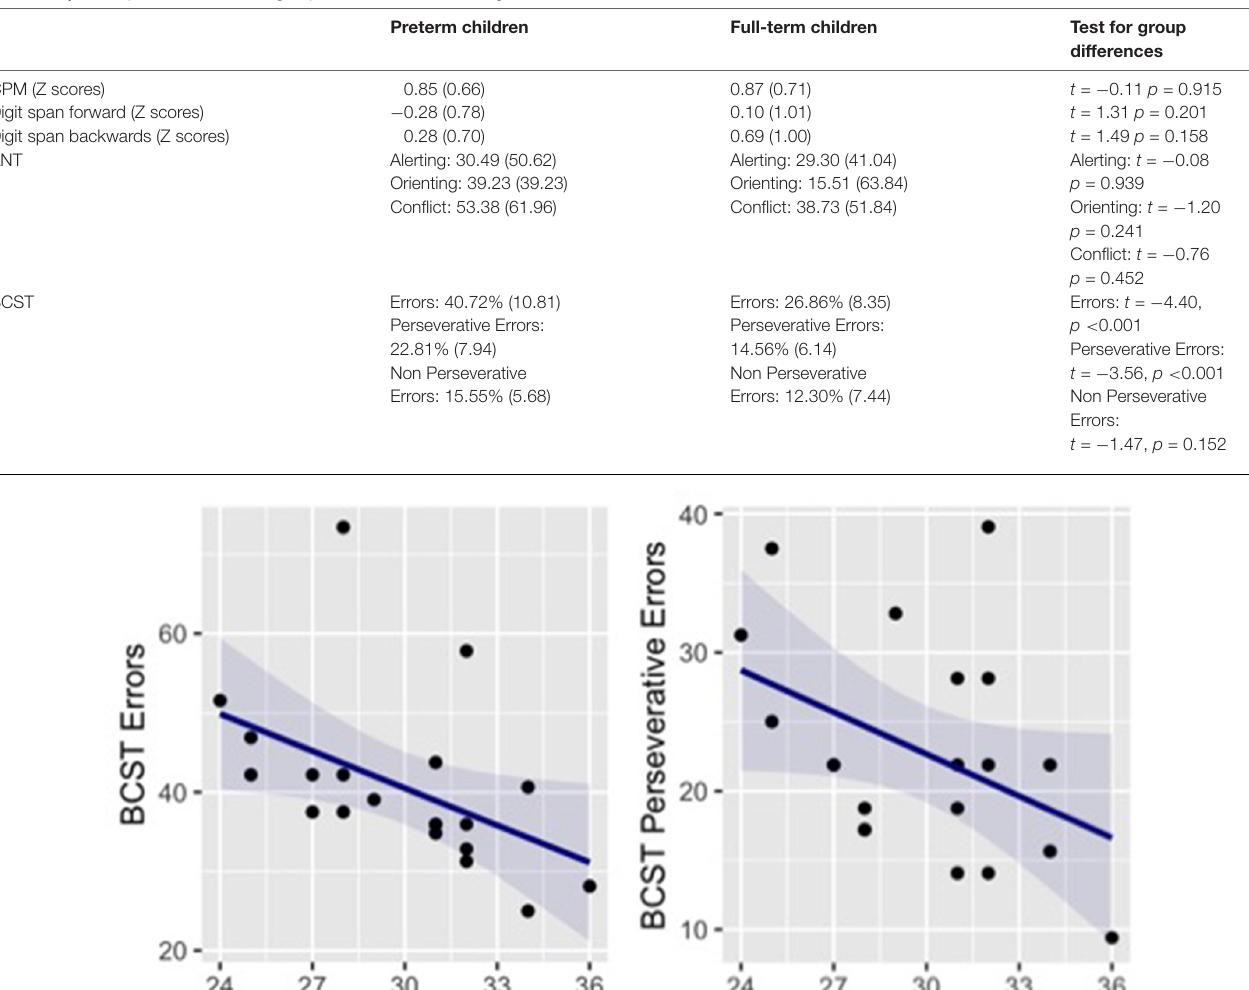
TABLE 2 | Descriptives and tests for group differences for each cognitive test.